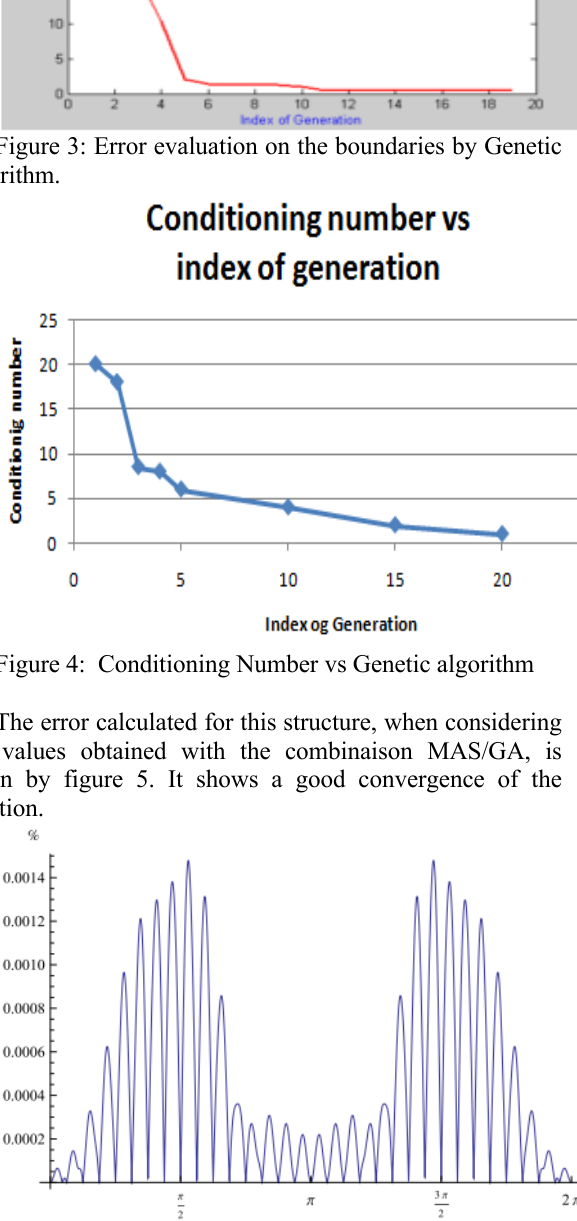
Figure 5: Error in boundary conditions obtained with Genetic Algorithm for the cylinder with radius 𝑟 = 0.6 𝜆 The radar cross section (RCS) is defined for 2D by equation (10) is given in figure 6 for the same cylinder.